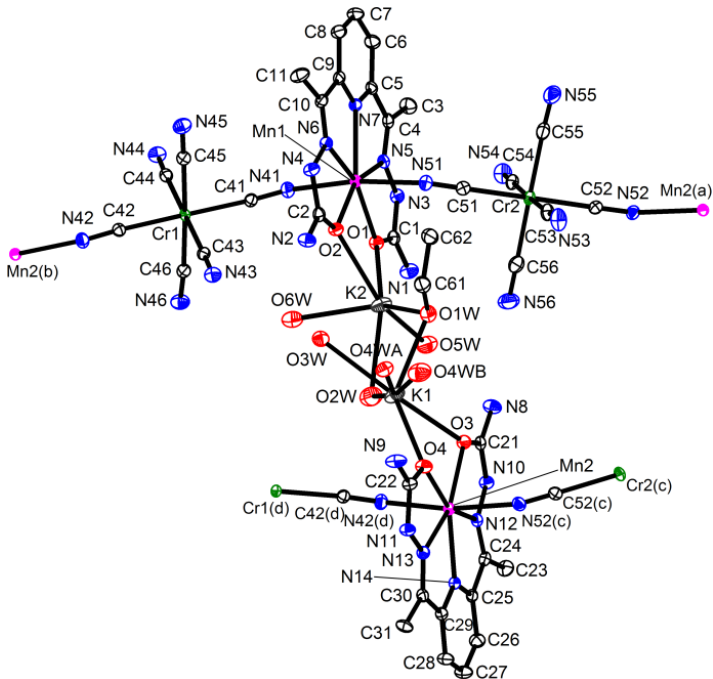
Figure 1. Asymmetric unit in 1 with atom numbering scheme (ORTEP drawing with 50% probability ellipsoids, solvate water molecules are omitted for clarity). Colored atoms: Cr (green), K (grey), Mn (magenta), N (blue), O (red). Symmetry codes: (a) ( − x , y − 0.5, − z ), (b) (1 − x , y − 0.5, 1 − z ), (c) ( − x , y + 0.5, − z ) and (d) (1 − x , y + 0.5, 1 − z ).